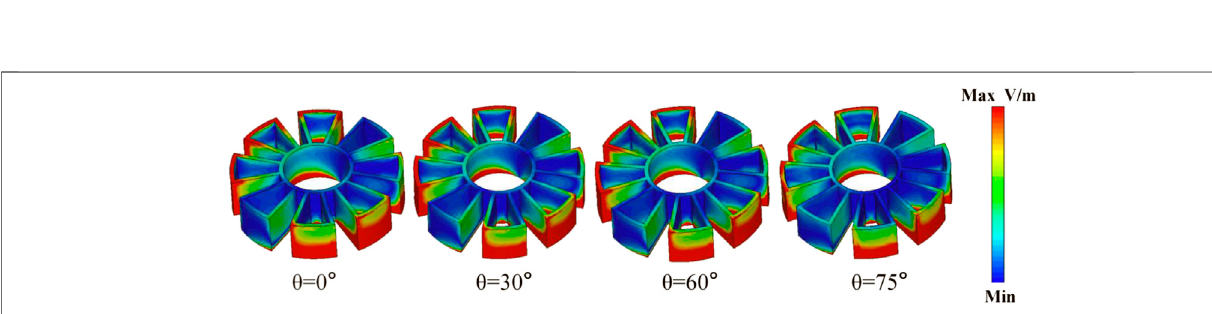
FIGURE 6 | Absorption spectra for (A) different polarization angles φ and different incidence angles θ for (B) TE, and (C) TM polarization.